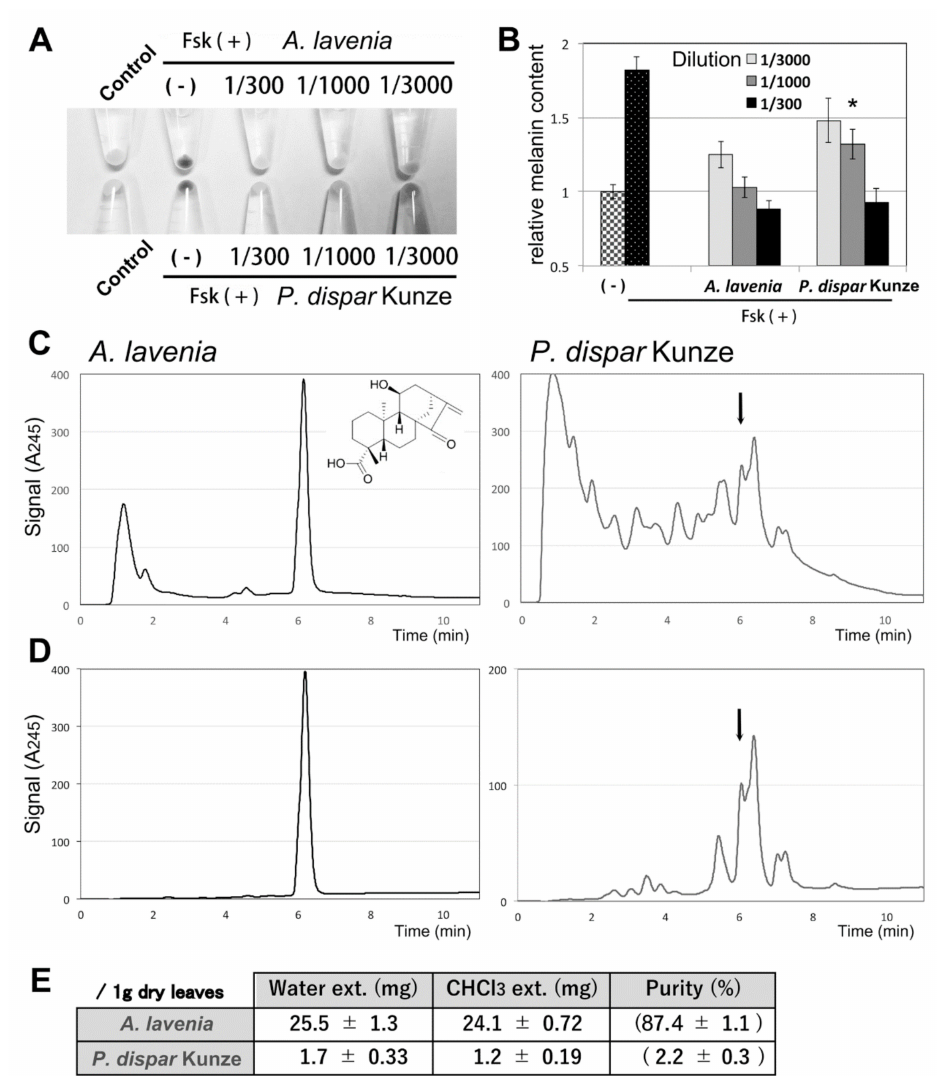
Figure 2. ( A ) B16F10 cells were treated with water extracts of A. lavenia and P. dispar Kunze (prepared with 20 volumes of water) at the indicated fold dilution (1 / 300, 1 / 1000, 1 / 3000) in the medium. When the water extracts were dried, 1 mL extracts from A. lavenia and P. dispar Kunze dried leaves (50 mg each) produced approximately 9 mg and 12 mg of precipitants, respectively. Thus, the 1 / 1000 dilution produced 9 µ g / mL and 12 µ g / mL, respectively. Melanogenesis was induced by 20 µ M of forskolin (Fsk) for 48 h. ( B ) Melanin content was measured at OD 405 after NaOH extraction. The values were first normalized by the total protein, and the relative content in the control (without forskolin) was set to 1. The means and SD are indicated, n = 3. * indicates p < 0.05 between A. lavenia and P. disper Kunze. ( C ) LC-UV analyses of the water extracts. An arrow indicates a peak for the candidate of 11 α OH-KA that was detected by LC-MS (see Materials and Methods). ( D ) LC-UV analyses of water extracts after purification with 1 volume of CHCl 3 . ( E ) A summary of 11 α OH-KA content in the fractions of water extracts (prepared from 1 g leaves with 2 times 20 volumes of water) and those followed by CHCl 3 extraction. The purity of 11 α OH-KA in the final fractions (water followed by CHCl 3 ) was calculated from the total dry weight of the final fractions (27.5 mg and 54.5 mg, respectively). The LC-UV analyses suggested that 11 α OH-KA was the major component in the A. lavenia water extract (Figure 2C, left). In contrast, no clear peak for 11 α OH-KA was detected when the P. disper Kunze extract was analyzed (Figure 2C, right). The LC-MS analyses suggested that the peak indicated by an arrow corresponded to 11 α OH-KA (data not shown). These results indicate